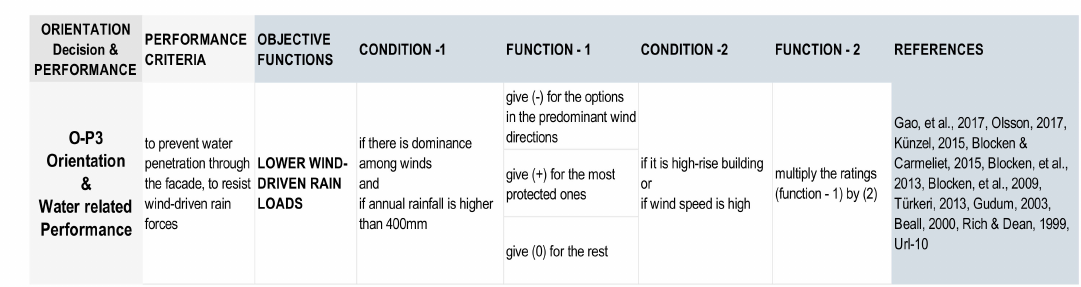
Figure 3. Section from the tool process (screenshot from the tool)